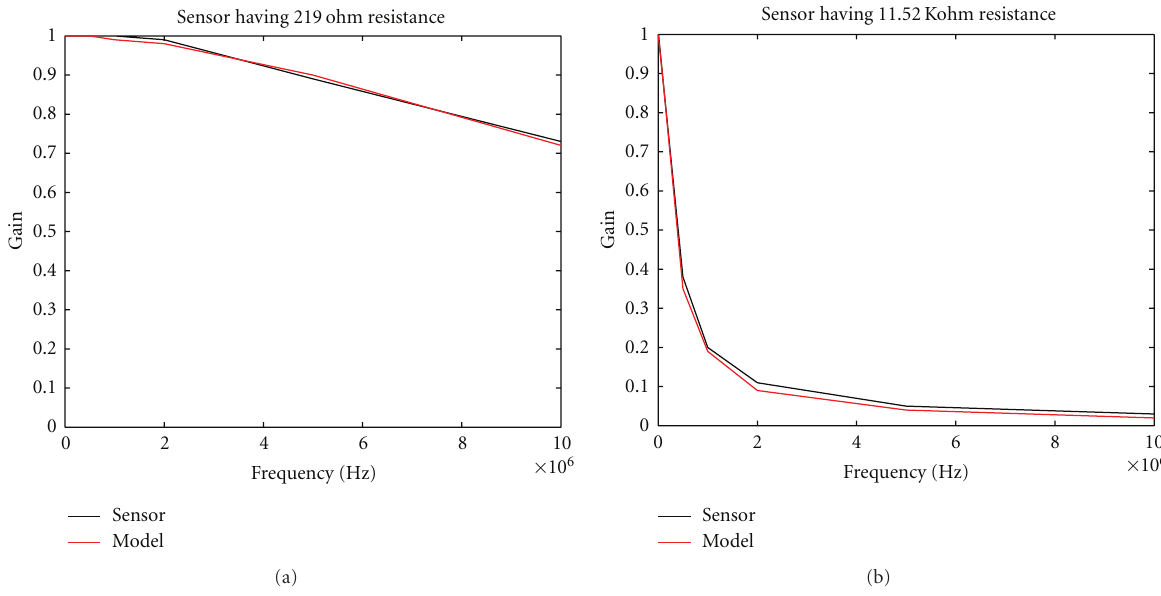
Figure 3: (a) Comparison of the gain-frequency response of a sensor modeled low resistance (219 Ω resistance) with the actual experimental data. (b) Comparison of the gain-frequency response of a sensor modeled high resistance (11.52K Ω resistances) with the actual experimental data. The “sensor” implies the experimental data, and the “model” implies modeled/simulated data using MULTISIM.